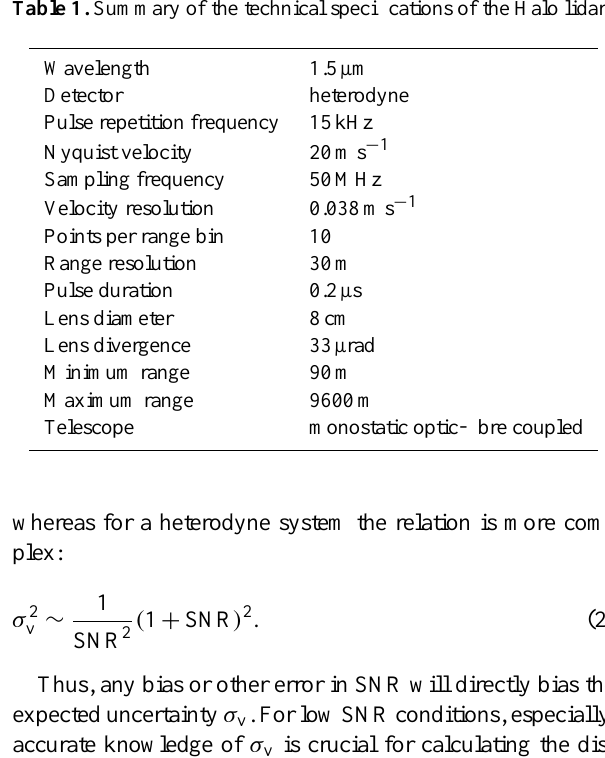
Table 1. Summary of the technical specifications of the Halo